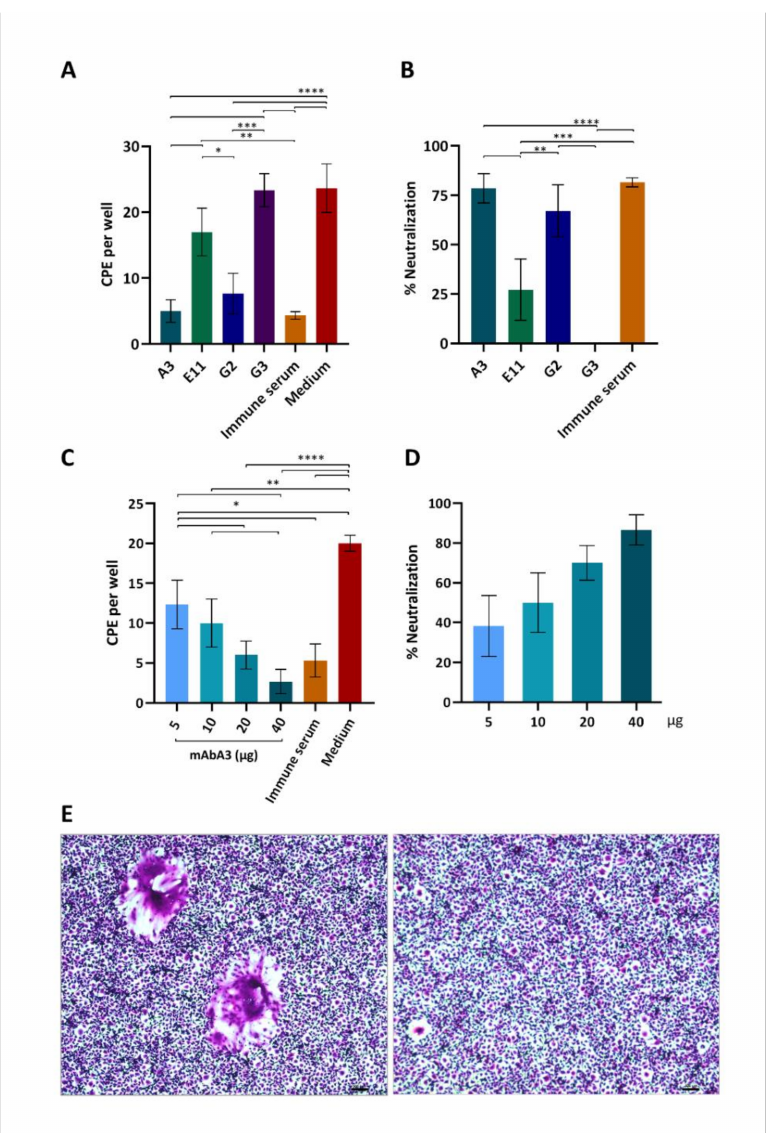
Figure 5. Monoclonal antibody A3-mediated neutralization of PEDV infectivity. ( A ) Preliminary experiments using 10 µ g of mAbA3, mAbE11, mAbG2 and mAbG3 to mix with 100 pfu of PEDV P70 G2 strain before adding to the Vero cell monolayer. Infected cells treated with mouse immune serum to rS1 (IS) and infected cells in medium alone served as positive and negative neutralization